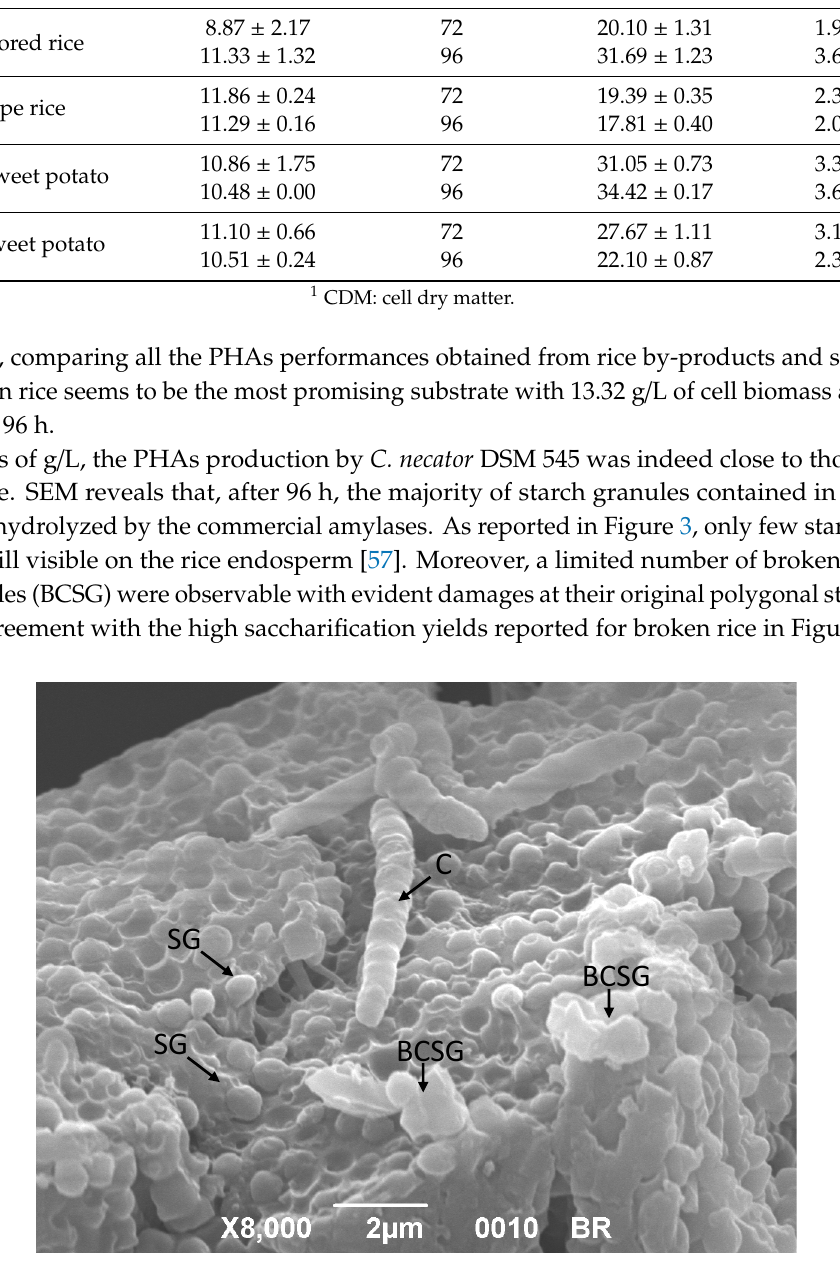
Figure 3. SEM micrograph of 3% w / v broken rice under the SSF regime with STARGEN™ 002 and C. necator DSM 545. C. necator DSM 545 (C), starch granules (SG). Broken compound starch granules (BCSG), with evident damages at their original polygonal structure, are visible on rice